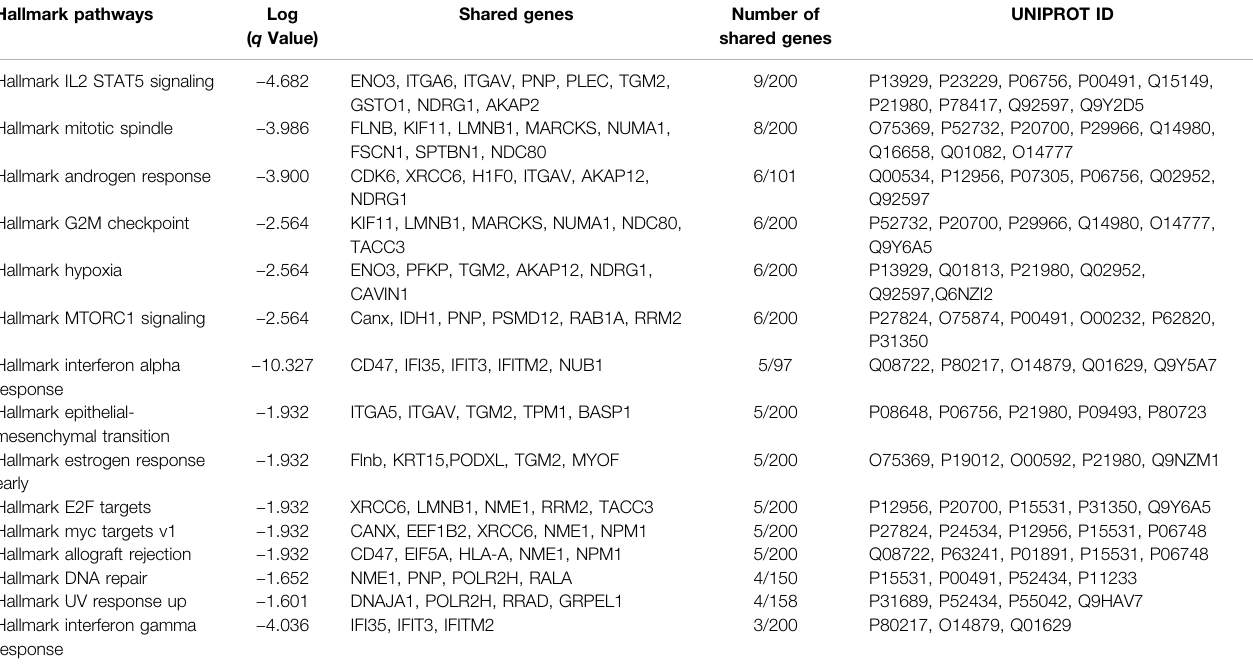
TABLE 3| Hallmark pathways identi fi ed using Metascape (Metascape.com) for differentially expressed proteins between control and TGF- β -treated RAS-activated ATII ER:KRASV12 cells. Hallmark